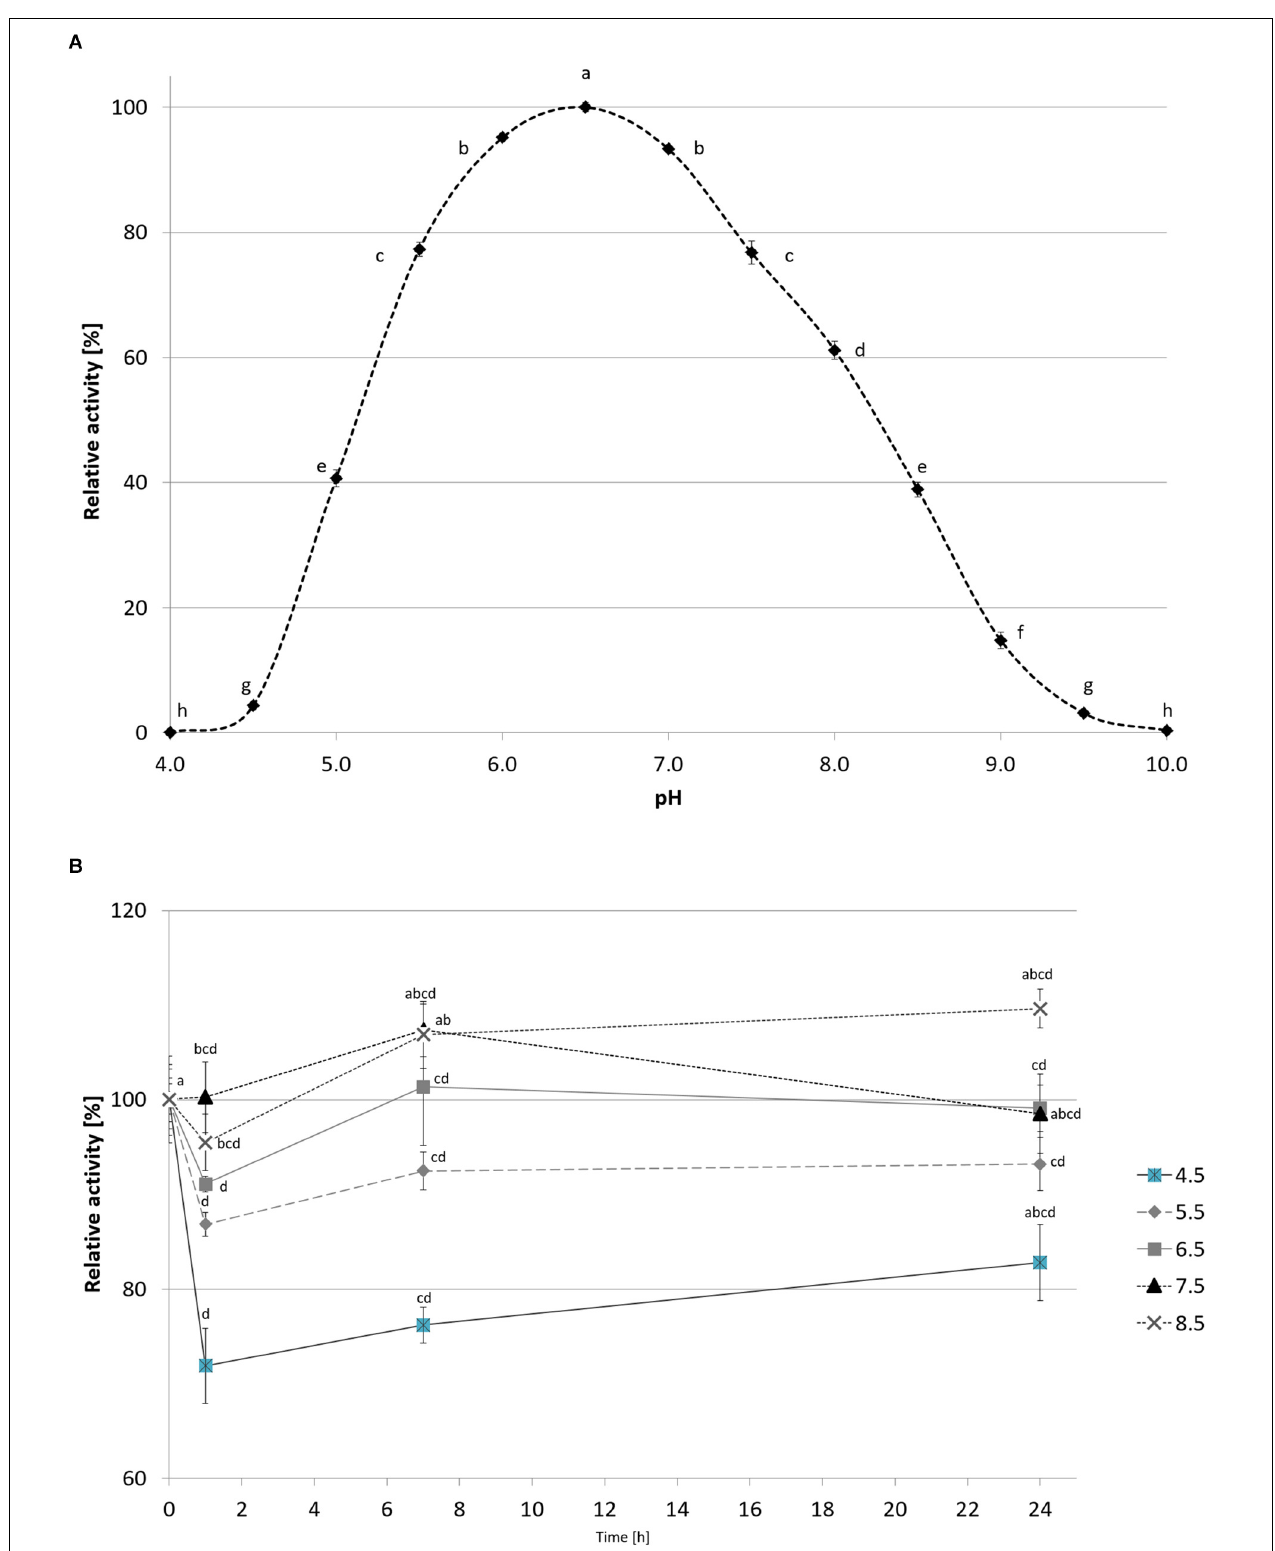
FIGURE 7 | The effect of pH on recombinant CelRH5 activity (A) and stability (B) . Activity toward OBR-HEC was determined at 20 mM Britton-Robinson buffer at 20 ◦ C. The error bars represent the standard deviation ( n = 3) and different letters mean statistically significant differences.